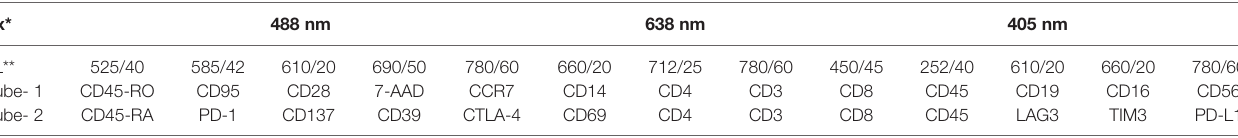
TABLE 2 | Suggested panel for the evaluation of immune checkpoints in leukemia